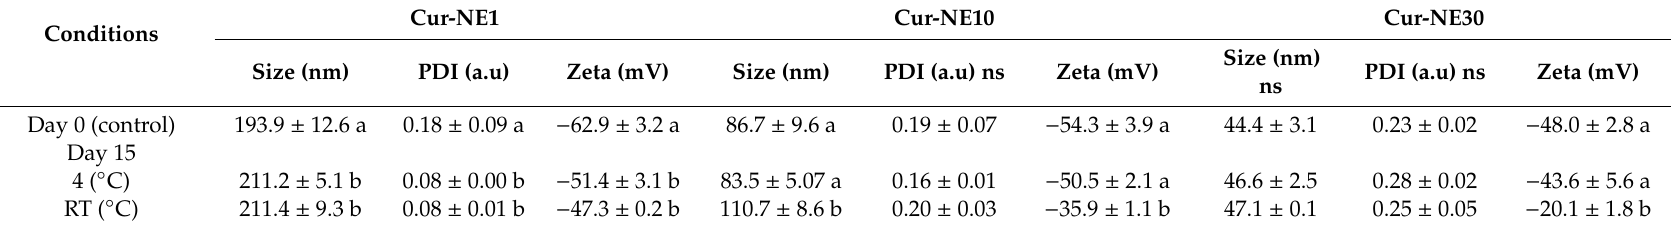
Table 3. Average diameter, size distribution, and surface charge of Cur-NEs after 15 days storage at 4 ◦ C and room temperature, RT ( ◦